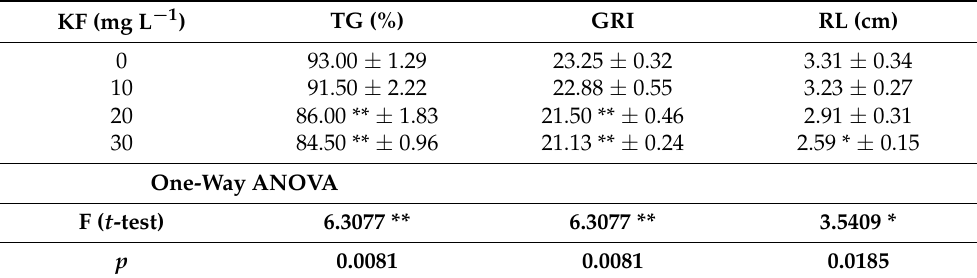
Table 1. Total germination (TG) percentage, germination rate index (GRI), and root length (RL) of Lactuca sativa L. seedlings after 7 days of exposure to potassium fluoride (KF) at 0 mg L − 1 , 10 mg L − 1 , 20 mg L − 1 , and 30 mg L − 1 .